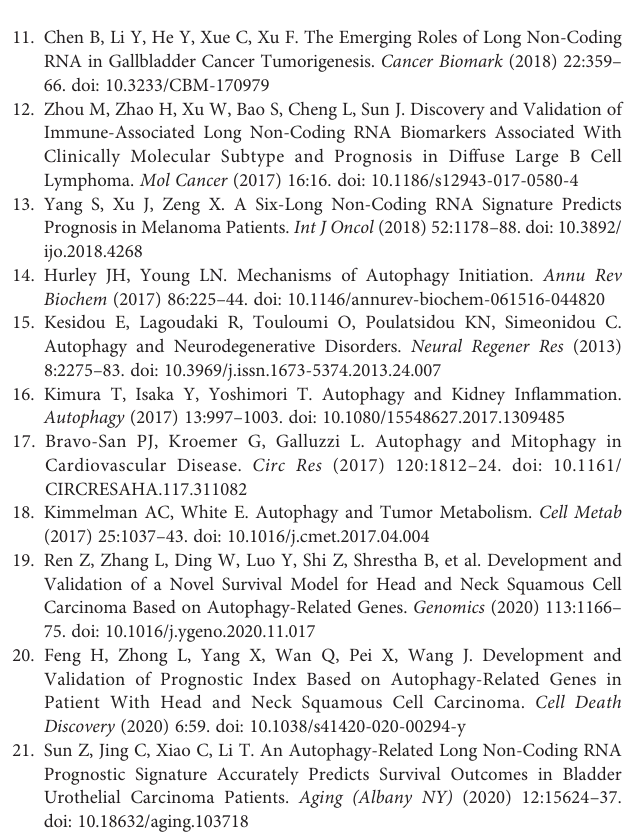
Supplementary Figure 1 | Kaplan-Meier curves of associations between signature lncRNAs and prognosis in HNSCC patients. (A) MYOSLID; (B) LINC00958; (C) AL450992.2; (D) AL160006.1; (E) AL139287.1; (F) AL022328.2; (G) AC116914.2; (H) AC104083.1; (I) AC068580.1. Supplementary Figure 2 | Relation between autophagic signature lncRNAs and clinical parameters. (A) gender (female vs. male); (B) grade (G1, G2, G3, G4); (C) AJCC Stage (Stage I, II, III, IV); (D) T stage (T1, T2, T3, T4); (E) Stage N (N0, N1, N2, N3); (F) Stage M [M0, M1, MX (unknown)]. Supplementary Figure 3 | Expression levels of signature lncRNAs between normal tissues (n=44) and tumor tissues (n=502). (A) heatmap and (B) boxplot. Supplementary File S1 | Original